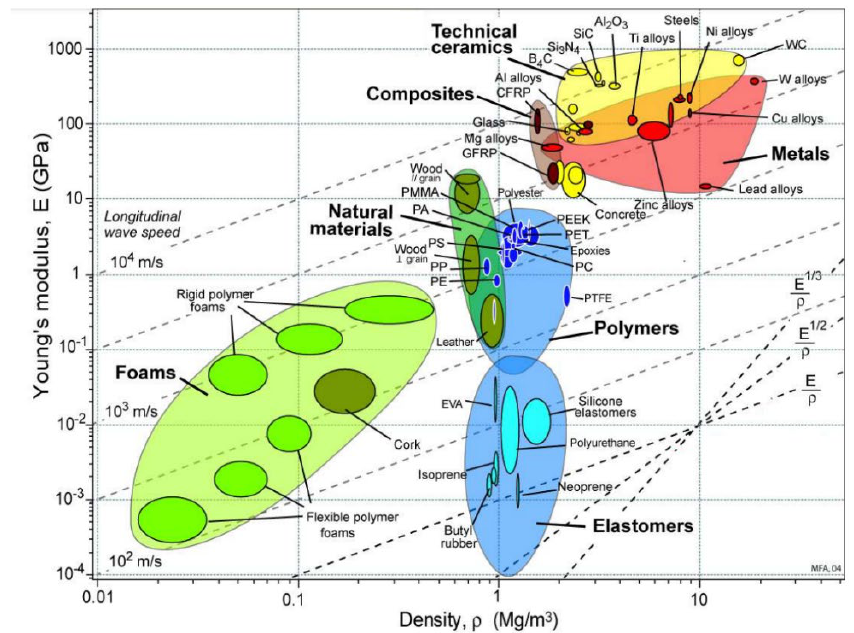
Figure 4. Wind turbine blade materials [17].